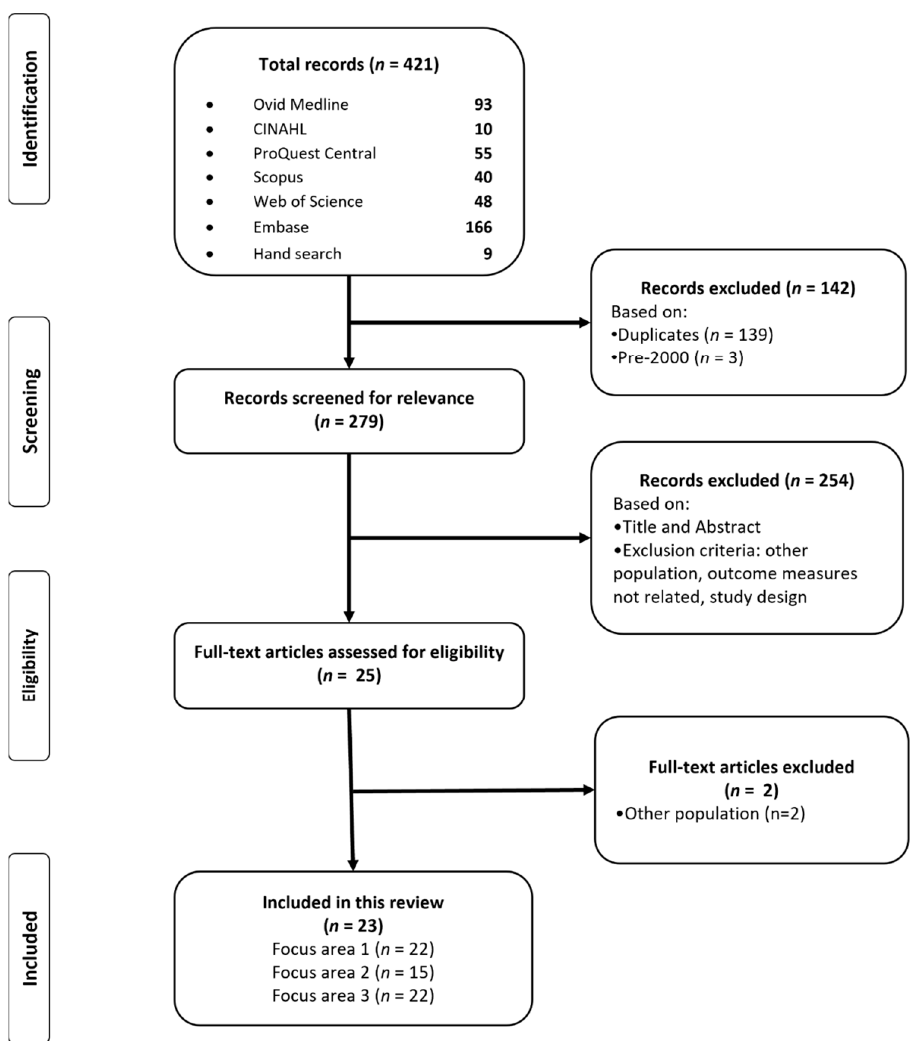
Figure 1. PRISMA flow chart of the study selection process.